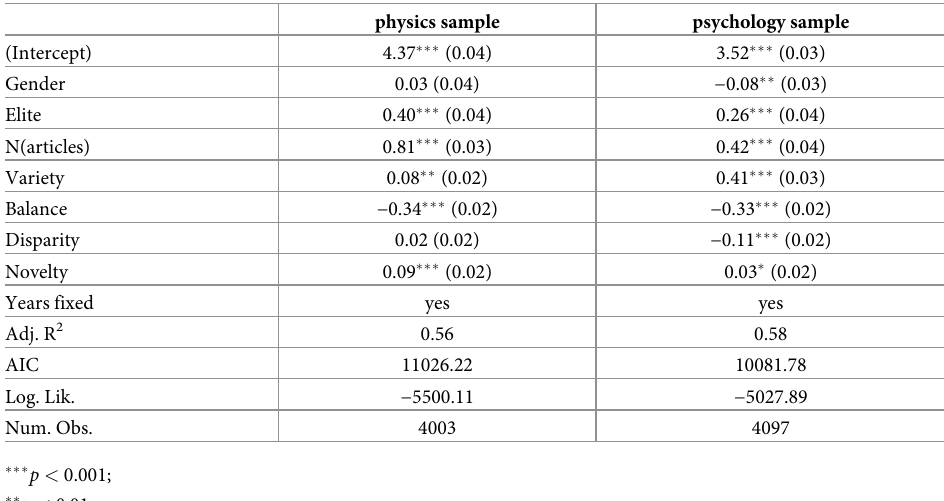
Table 3. Results of the linear regressions on the logged citation